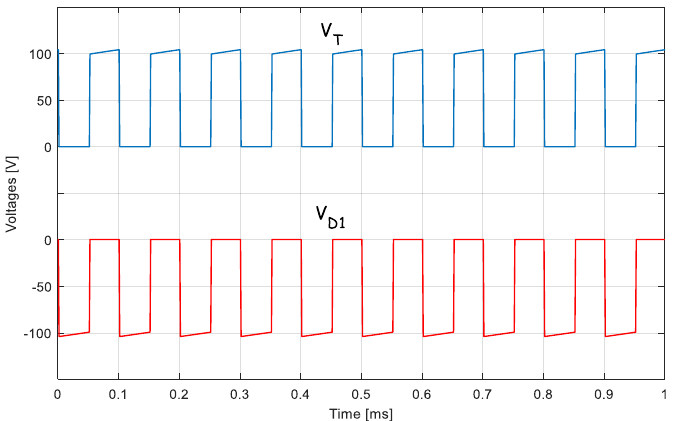
Figure 7. Simulation results of the voltage across the power switch S W and the diode D 1 in buck